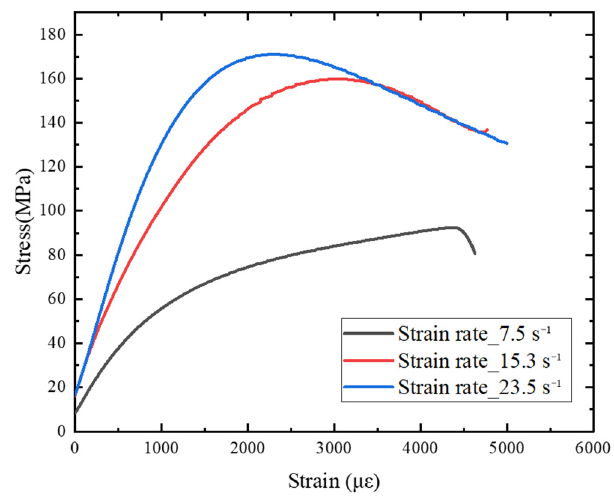
Figure 8. Dynamic stress–strain curve at different strain rates.